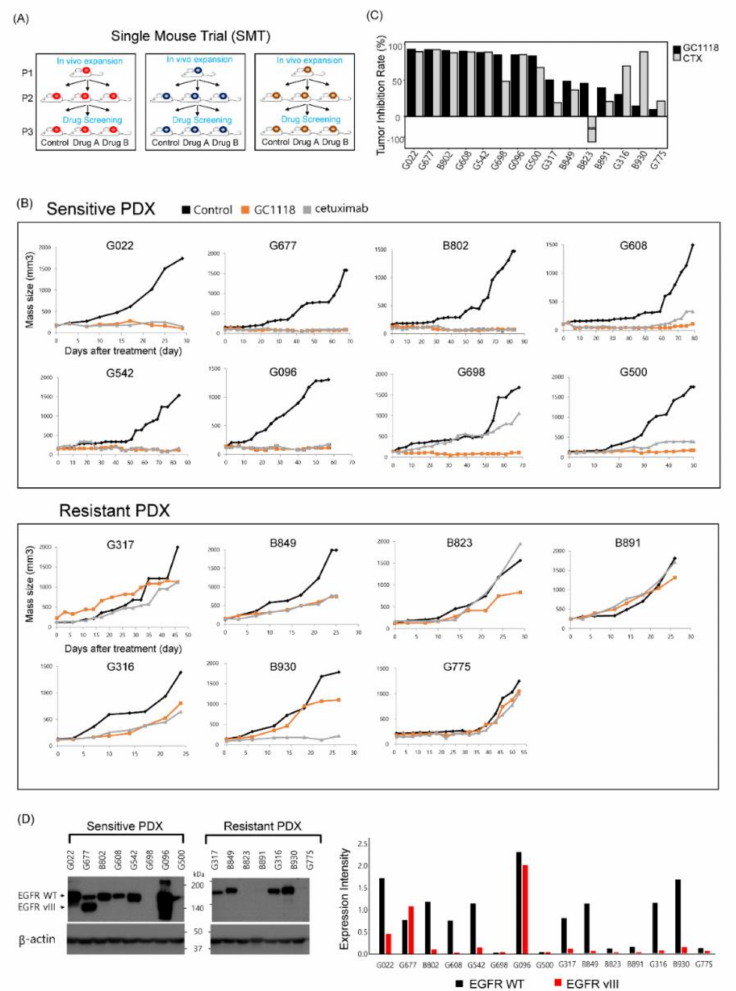
Figure 1. Single-mouse trial to evaluate the anti-tumor e ffi cacy of GC1118 against glioblastoma (GBM) using patient-derived xenograft (PDX) models. ( A ) A schematic illustration of the study design to evaluate the anti-tumor e ff ect of GC1118 using GBM PDXs; ( B ) the anti-tumor e ff ect of GC1118 in xenograft models. Mice were treated with phosphate-bu ff ered saline alone, cetuximab (50 mg / kg), or GC1118 (50 mg / kg) twice a week. Tumor volume was measured twice a week. GC1118 sensitivity was determined according to the tumor inhibition rate as defined below; ( C ) tumor inhibition rate as a measure of anti-tumor e ffi cacy (tumor inhibition rate (TIR): ((1-(volume of treated tumor) / (volume of control tumor)) × 100(%)). PDX models with TIR exceeding 50% were defined as sensitive to treatment; ( D ) expression levels of wild-type (WT) epidermal growth factor receptor (EGFR) and EGFRvIII in PDXs detected using Western blotting. Bar plot represents expression levels of WT EGFR and EGFRvIII normalized to that of β